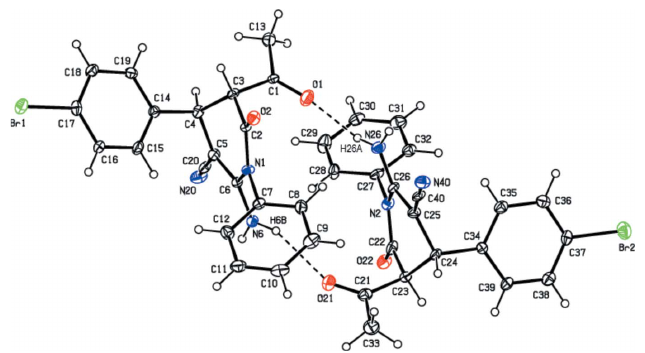
Figure 1 Asymmetric unit of the title compounds showing two crystallographically independent molecules, A and B . Displacement ellipsoids are drawn at the 30% probability level. The intermolecular N—H (cid:2)(cid:2)(cid:2) O hydrogen bonds are drawn with dashed